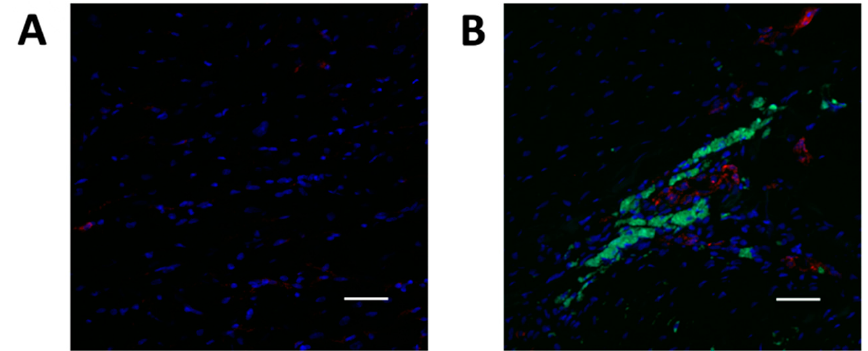
Figure 4. Neonatal sheep cardiovascular progenitor cell retention in the post-infarct repair region. In the non-infarcted region of the left ventricle, newly introduced cells were not identified ( A ). Carboxyfluorescein succinimidyl ester (CFSE) labeled (green) cells were identifiable in the region surrounding the infarction ( B ). Anti-von Willebrand Factor labeled endothelial cells were identified using Alexa Fluor 647 (red). Scale bar: 50 µm.